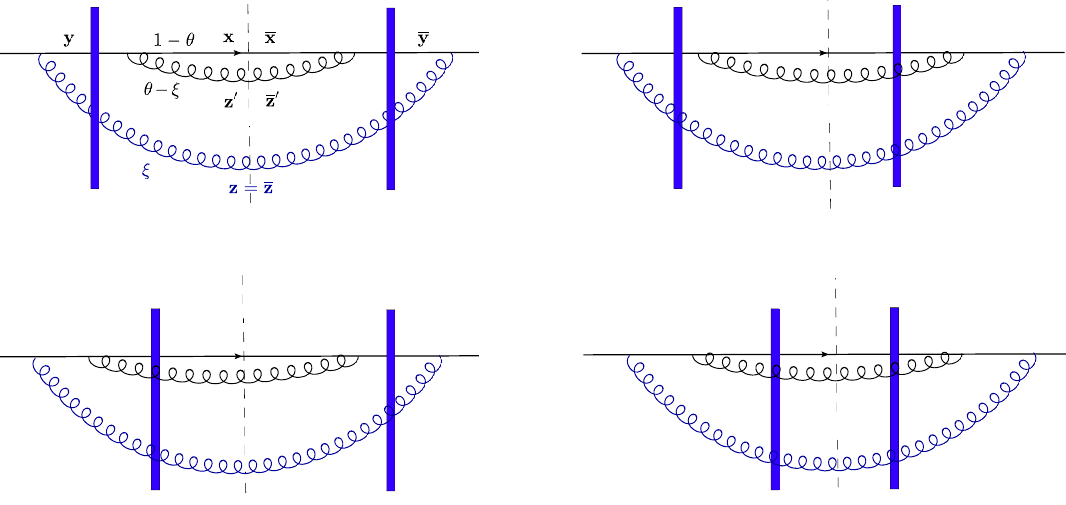
Figure 22 . The four graphs contributing to the limit where the first gluon emission (depicted in blue) is collinear. These graphs are free of initial-state